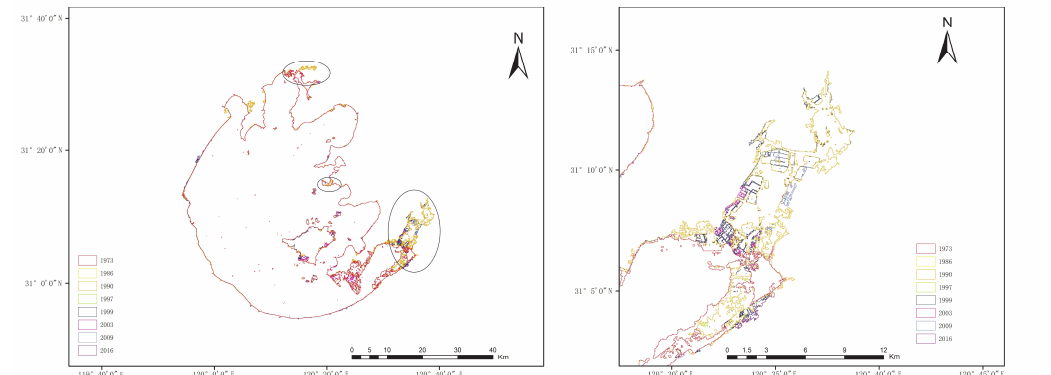
Figure 3. Lake boundaries extracted from Landsat imagery and the enlarged views of shoreline